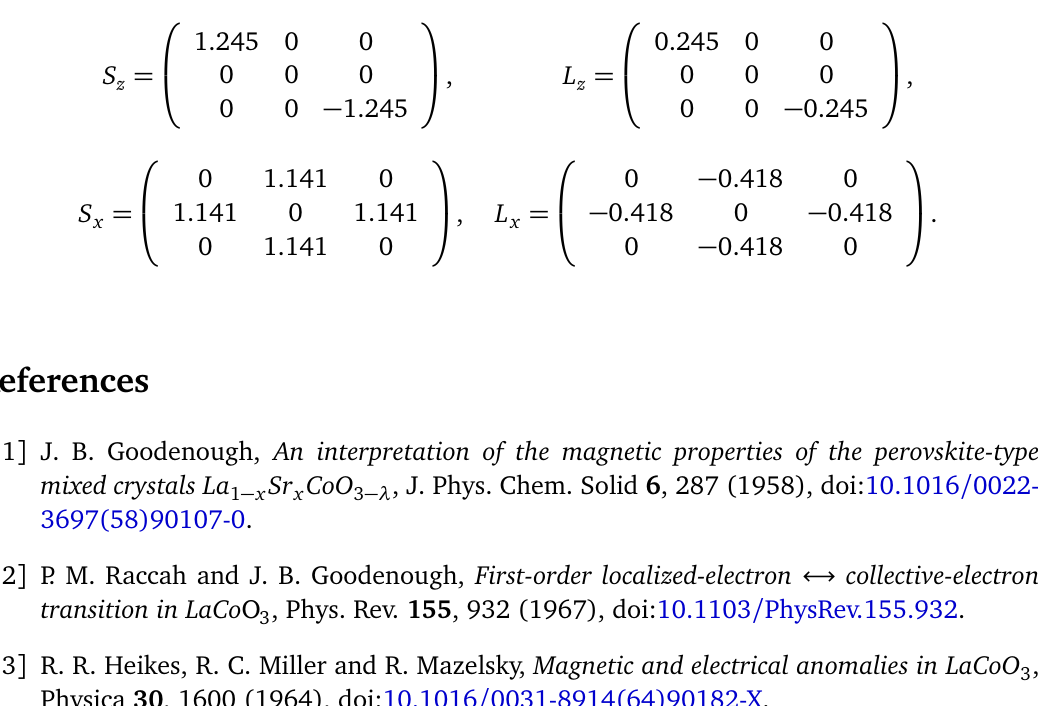
Figure 9: Energy differences at various magnetization directions of SOC for (a) = 4 eV, (b) U = 5 eV, and (c) U U ef f ef f hopping amplitudes have only diagonal matrix elements, t ( z ) = 0.002, and t ( z ) = − t 44 55